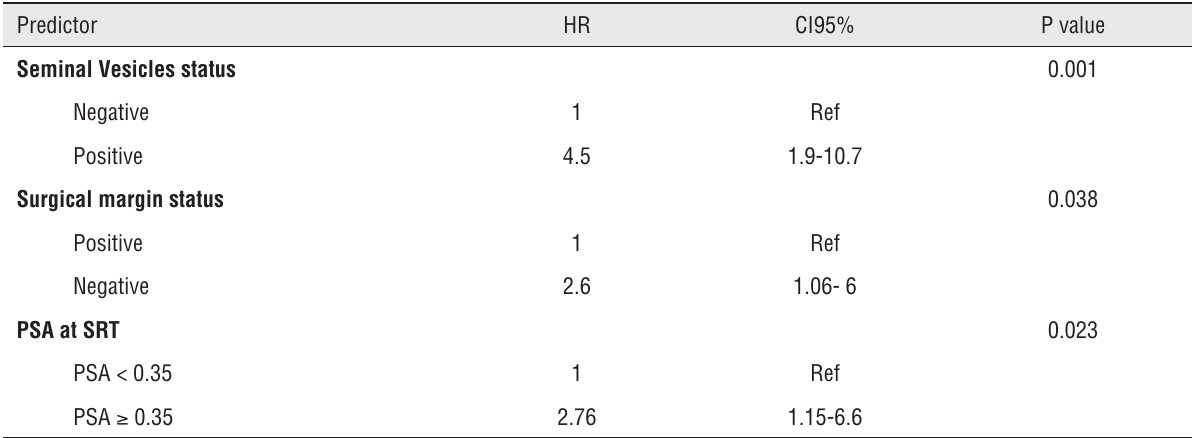
Table-3 - Cox regression analysis with bootstrapping resample for predictive factors associated with BCR after SRT. Predictor